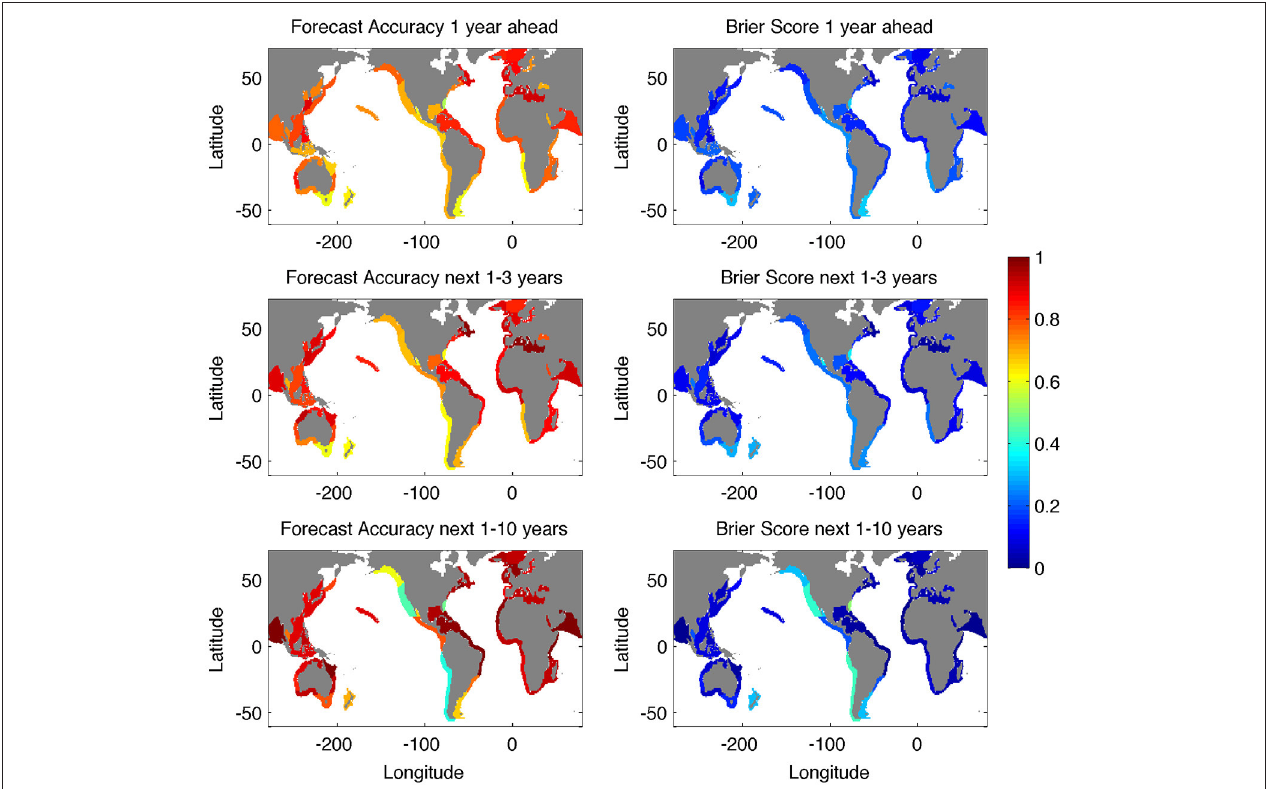
FIGURE 2 | Forecast accuracy (left) and Brier Score (BrS, right ) for upper SST tercile predictions for a 1 year ahead forecast and over the next 3 and 10 years. Forecast accuracy ranges between 0 (no skill) and 1 (perfect skill). The BrS ranges from 0 (perfect score) to 1 (no skill).